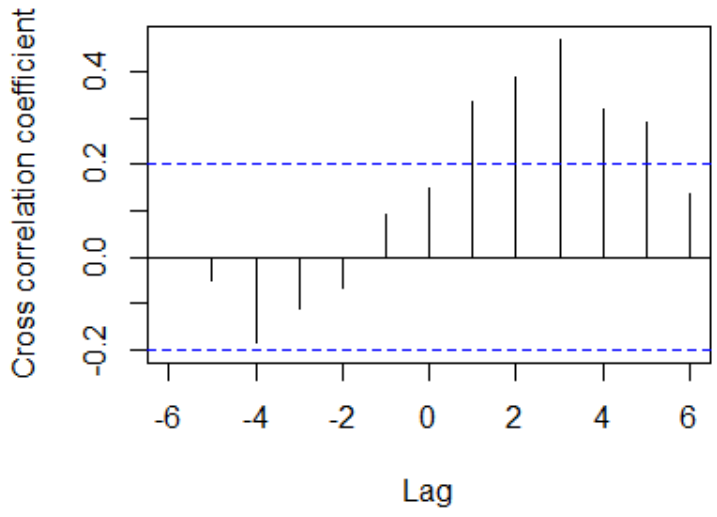
Figure 4. Remote sensing-based indicators of crop-land in Hu County. NDVI, normalized difference vegetation index; FPAR, fraction of photosynthetically active radiation absorbed by vegetation; LAI, leaf area index; GPP, gross primary productivity; PsnNet, net photosynthesis; LST, land surface temperature.